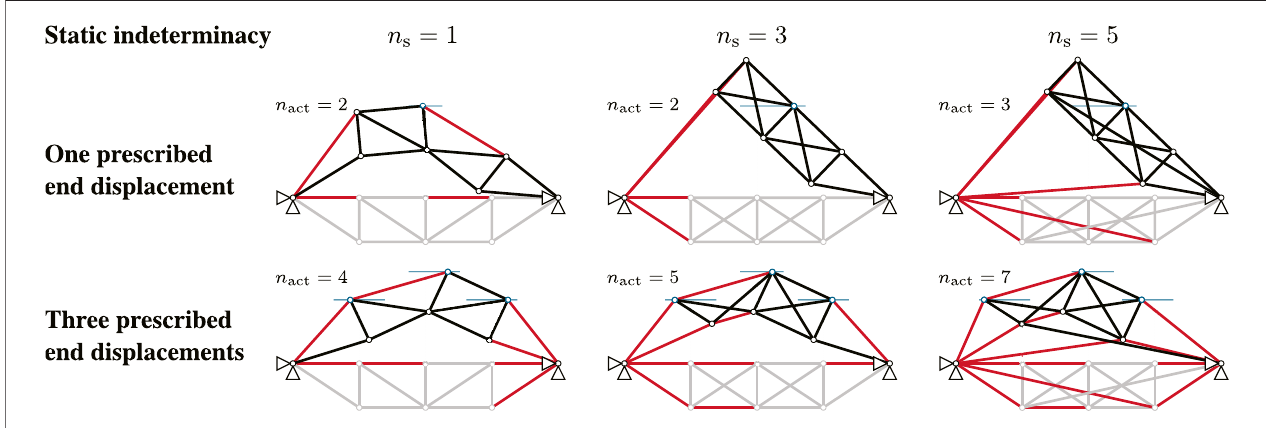
FIGURE7| Examplesofinternalactuatorlocations(markedinred)thatenablemotionthrougha fi nitemechanism. (A) Staticindeterminacy. (B) Oneprescribedend displacement. (C) Three prescribed end displacement.